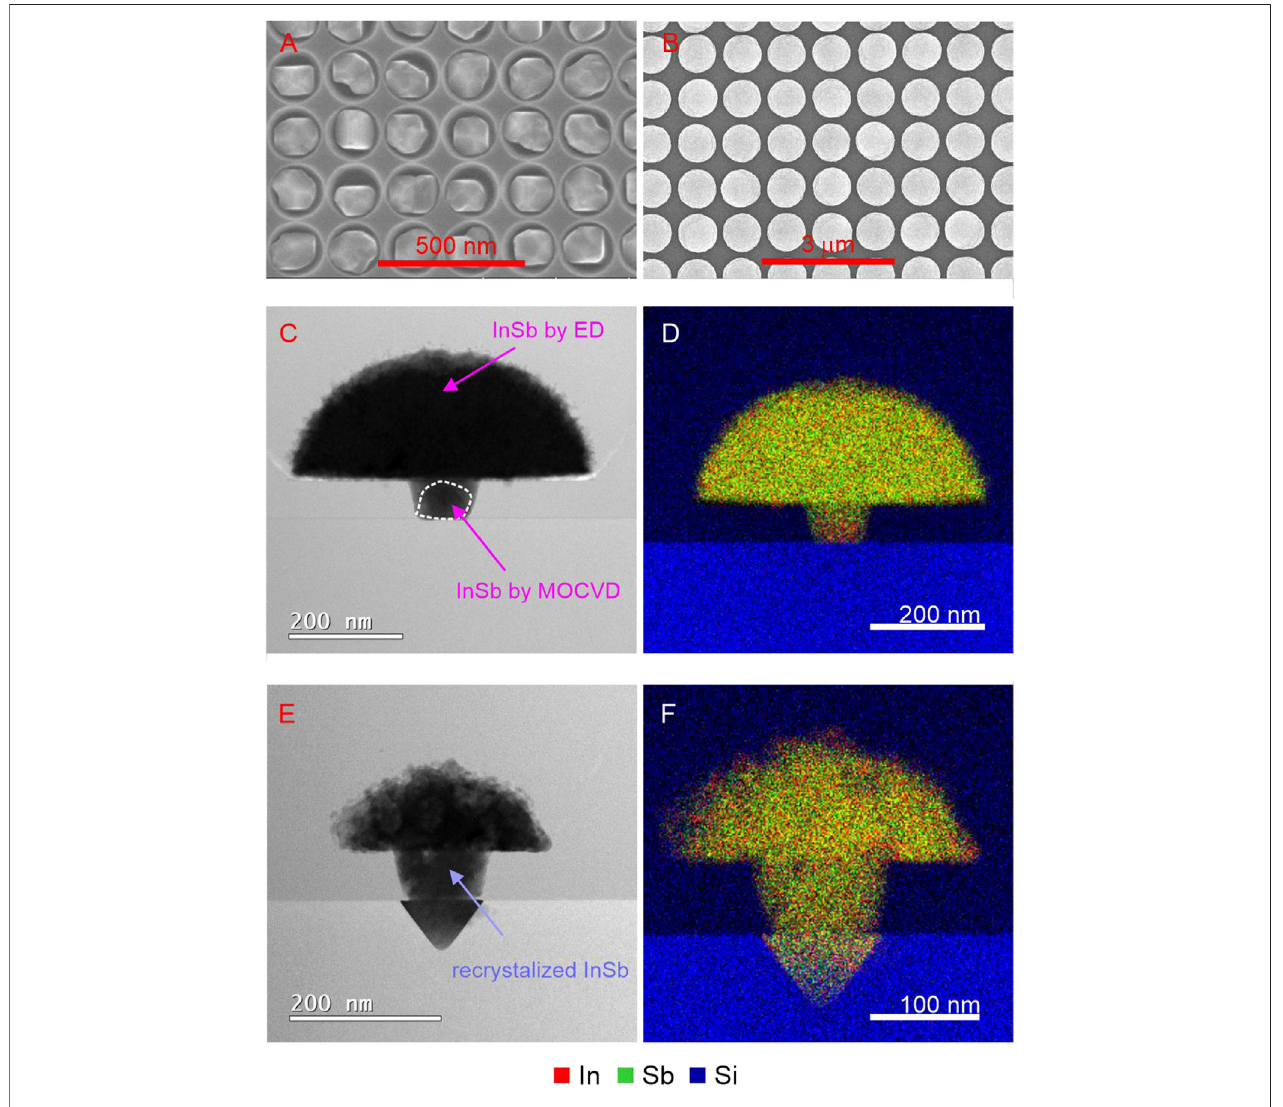
FIGURE6|(A) SEMimages ofdensearrayofInSbcrystallitesbyMOCVDserving asseedsforlater electrodeposition. (B) sparser arraysimilar to (A) withthesmall InSb seeds after the electrodeposition step resulting in large InSb mushrooms. (C) (S)TEM cross-section image of a representative structure from (B) together with (D) EDX map of In, Sb, and Si elemental distribution. (E) (S)TEM image of (B) after melting and crystallization. (F) EDX map of (E) .